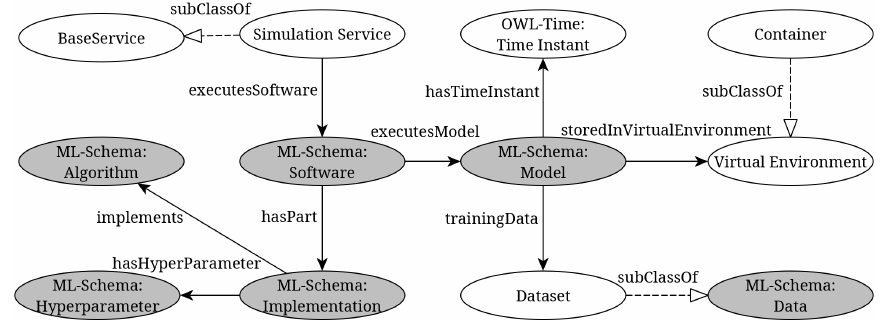
Figure 5. Main Simulation Service—Domain Ontology concepts and their